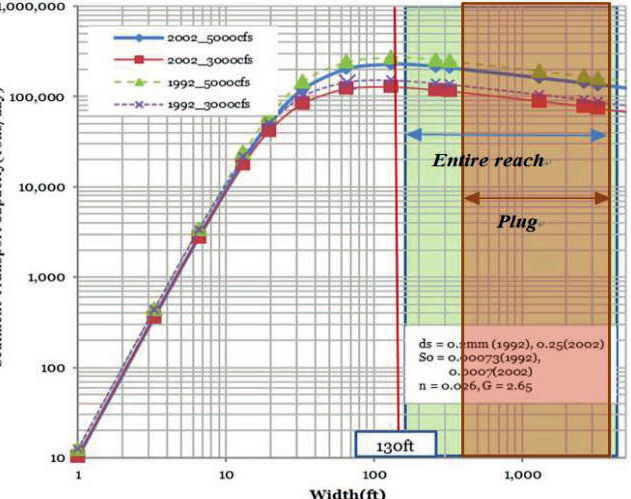
Fig. 2 Sediment transport capacity vs channel width of the Rio Grande from Park